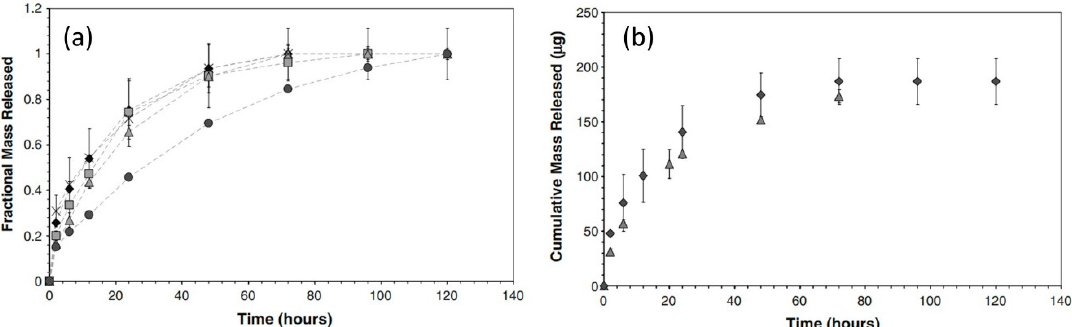
Figure 3. ( a ) Fractional release of HA from imprinted Nelfilcon hydrogels with di ff erent proportions of functional monomers. Dynamic release profiles were normalized with the total amount of HA released by hydrogels prepared from di ff erent proportions of functional monomers [AM:NVP:DEAEM], all at 0.125%-by-mass of prepolymer (monomers mixture): [1:1:0] (gray squares), [1:1:2] (black diamonds) and [0:0:1] (crosses). For comparison, the fractional release profiles of hydrogels with 0.25% [1:1:2] (circles) and hydrogels with no functional monomers (gray triangles) are also plotted. ( b ) Cumulative Release of HA from Nelfilcon hydrogels before and after heat-sterilization. When hydrogels containing HA with Nelfilcon were heated to 121 ◦ C, the dynamic release profile of HA for such lenses (gray triangles) was similar to the release profile from hydrogels that did not undergo heat treatment (gray diamonds). From [41].